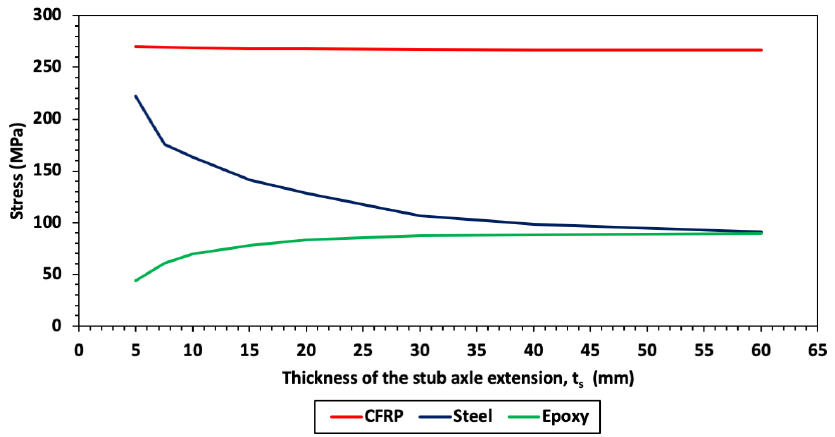
Figure 7. Maximum stress in each component of the hybrid metallic-composite railway axle assembly over a range of stub axle extension thicknesses.